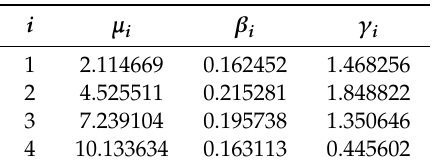
Table 3. The values for µ i , β i , and γ i , i = 1, ...